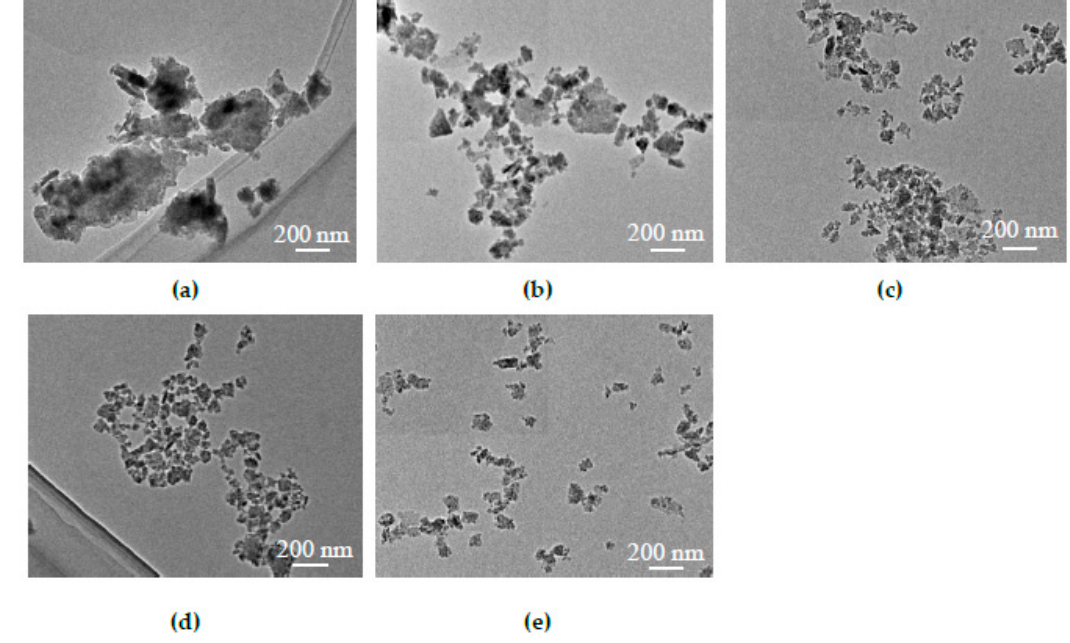
Figure 4. TEM images of CZTS dispersions with different centrifugal conditions. Distribution of CZTS particle size in inks with different centrifugal conditions ( a ) Without centrifugation; ( b ) 1500 rpm for 10 min; ( c ) 6000 rpm for 10 min; ( d ) 6000 rpm for 20 min; and ( e ) 6000 rpm for 30 min.